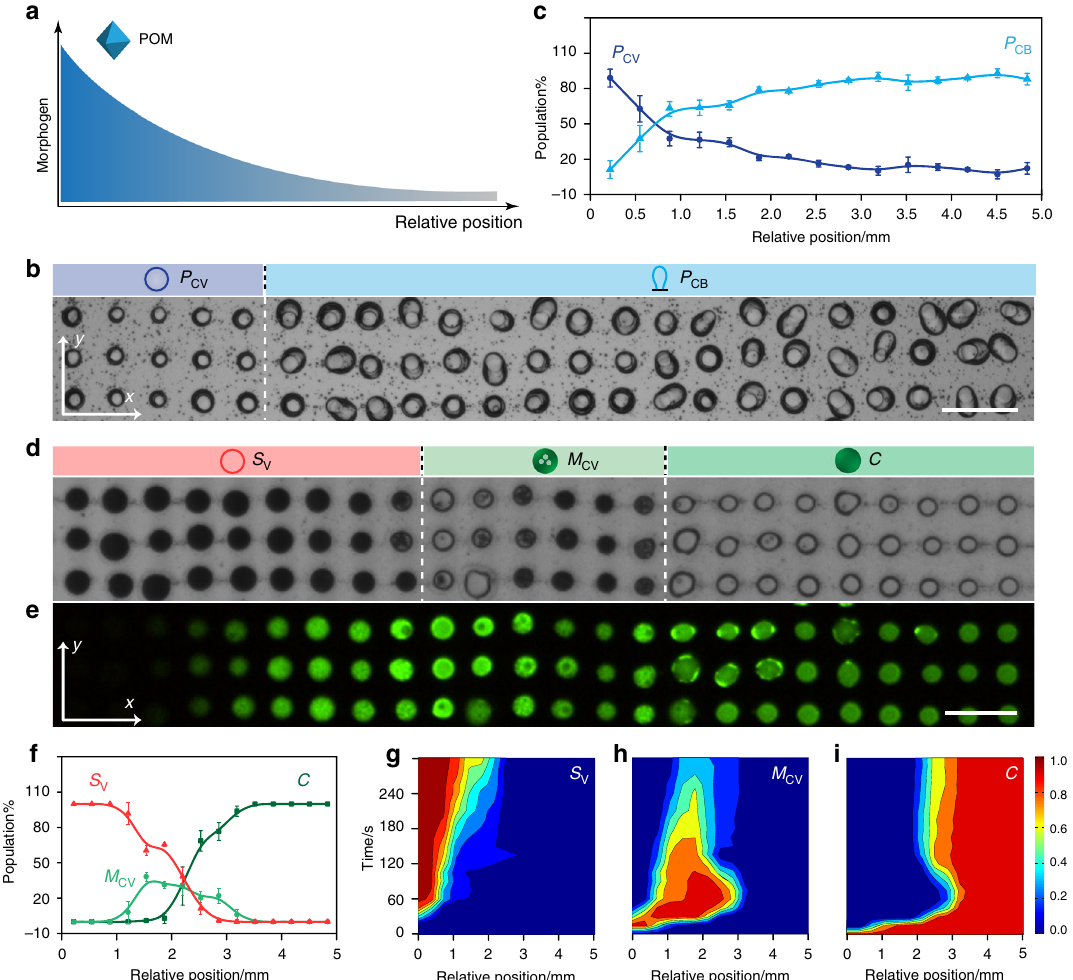
Fig. 2 Protocell differentiation in unidirectional gradients. a Graphical representation of a unidirectional POM chemical gradient ( x- axis). Similar experiments were undertaken with a SDS chemical gradient. b Optical microscopy image of an acoustically patterned array of PDDA/ATP coacervate droplets observed in the viewing window after exposure to a unidirectional POM diffusion gradient advancing along the x -axis. Images were recorded after no further changes in morphology were observed (15 min). Only a small section (3 × 23 droplet grid) of the array in the observation window is displayed. Sodium phosphotungstate (POM) is introduced into the chamber from the left-hand side of the image (50 µ L, 12.5 mM, fi nal POM concentration, 0.625 mM). Dashed white line marks the interface between the two differentiated protocell populations; spherical and balloon-shaped POM/coacervate vesicles, P CV (dark blue circle) and P CB (light blue graphic), respectively. Scale bar, 200 µ m. ( c ) Plot showing changes in the population number densities of P CV and P CB morphological types along the chemical gradient (from left to right along the x- axis) after POM-mediated differentiation under conditions as described in ( b ); number of counted protocells, n = 1500. d Optical microscopy image of a PDDA/ATP coacervate droplet array after exposure to a SDS chemical gradient advancing along the x -axis. Images were recorded after no further changes in morphology were observed (30 min). Only a thin section (3 × 24 droplet grid) of the array viewed in the observation window is displayed. SDS is introduced into the chamber (50 µ L, 50 mM; fi nal concentration, 2.5 mM) from the left-hand side of the image. Three spatially separated populations consisting of ATP-depleted SDS/PDDA vesicles ( S V ; red circle; left side), multi- compartmentalized coacervate vesicles ( M CV ; green circle with dots; centre) and native coacervate droplets ( C ; green fi lled circle; centre) are observed. Dashed white lines mark the interfaces between the differentiated protocell populations; scale bar, 200 µ m. e Corresponding fl uorescence microscopy image for ( d ); droplets were initially prepared with green fl uorescent TNP-ATP. f Plot showing changes in the population number densities of S V , M CV and C morphological types along the morphogen gradient (from left to right along the x -axis) after SDS-mediated differentiation under conditions as described in ( d ); number of counted protocells, n = 1500. g – i 2D plots showing spatial and temporal distributions of morphological types S V ( g ) M CV ( h ) and C ( i ) produced under conditions described in ( d ); colour scale represents percentage of a given population. Total number of counted protocells, n = 1500. The C to M CV transition occurs across regions of relatively high SDS concentration (left and centre-left) after approximately 30 s, followed by subsequent transformation to S V in areas of highest SDS concentration (far left). Coacervate droplets remain unchanged in domains of relatively low SDS concentration (right side). Source data are provided as a Source Data fi le. Error bars represent the standard deviation of the statistics count of the different lines of different protocells ( n =